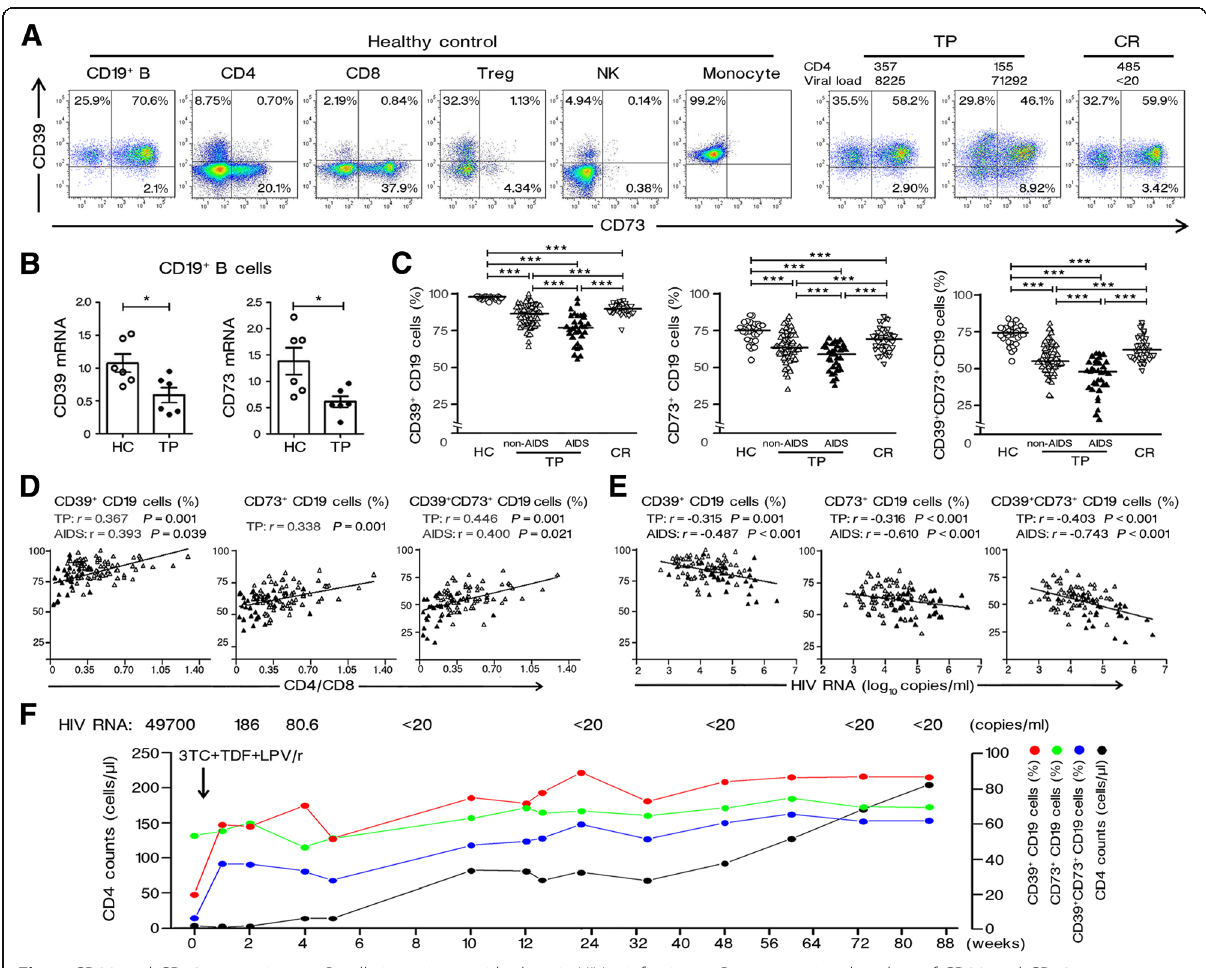
Fig. 1 CD39 and CD73 expression on B cells in patients with chronic HIV-1 infection. a Representative dot plots of CD39 and CD73-expressing cells from healthy individual and patients with chronic HIV-1 infection. b CD39 and CD73 mRNA expression in B cells isolated from HCs ( n = 6) and TPs ( n = 6). c Percentages of CD39 + , CD73 + , and CD39 + CD73 + B cells in the peripheral blood of TPs ( n = 100), CRs ( n = 36), and HCs (n = 36). Correlation analysis between the percentages of CD39 + , CD73 + , and CD39 + CD73 + B cells and CD4/CD8 ratios ( d ), and HIV RNA ( e ) in TPs. f The dynamic changes of CD39 + , CD73 + , and CD39 + CD73 + B cells in response to c-ART drugs (3TC + TDF + LPV/r). Data are mean ± SEM. *** p <